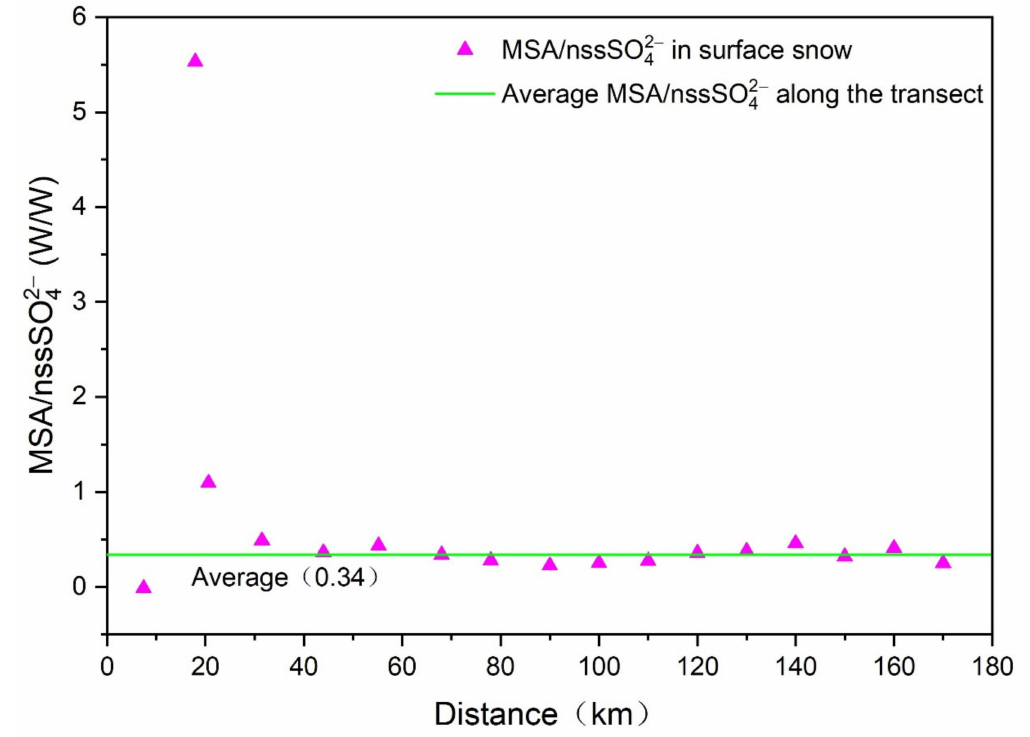
Figure 6. Variation of MSA/nssSO 42 − ratios in the surface snow samples from coast to inland. Ca 2+ concentrations also showed an overall decreasing trend with increasing distance from the coast and/or altitude. High Ca 2+ concentrations (ranged from 7.85 to 53.40 µ g L − 1 ) were measured between 7.4 and 55.2 km (285–955 m altitude). However, the data from the interior region between 68 and 170 km (1041–1852 m altitude) exhibited relatively low Ca 2+ concentrations (ranged from 1.44 to 14.76 µ g L − 1 ) (Figure 7). The detailed Ca 2+ concentrations of the surface snow samples along the transect are shown in Table 3. The Ca 2+ concentrations showed a significant correlation with distance from the coast or altitude (Table 4), implying that the spatial distribution of Ca 2+ from Zhongshan Station to LGB69 is also mainly affected by distance from the coast and/or altitude.